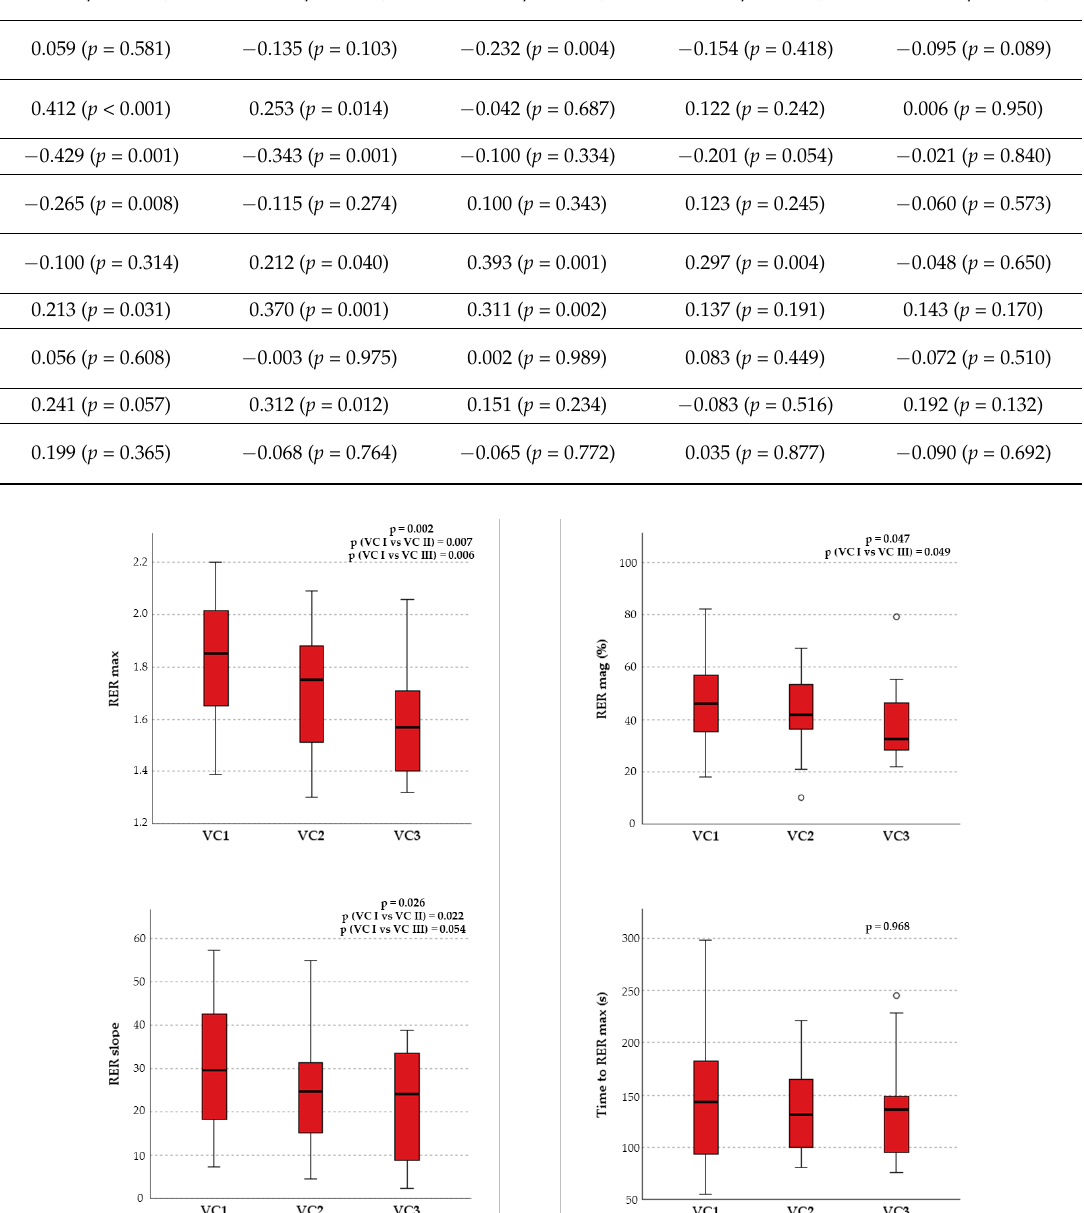
Figure 3. The RER overshoot parameters (RER max, RER mag, RER slope and Time to RER max) between patients of different ventilatory classes. VC= ventilatory class.